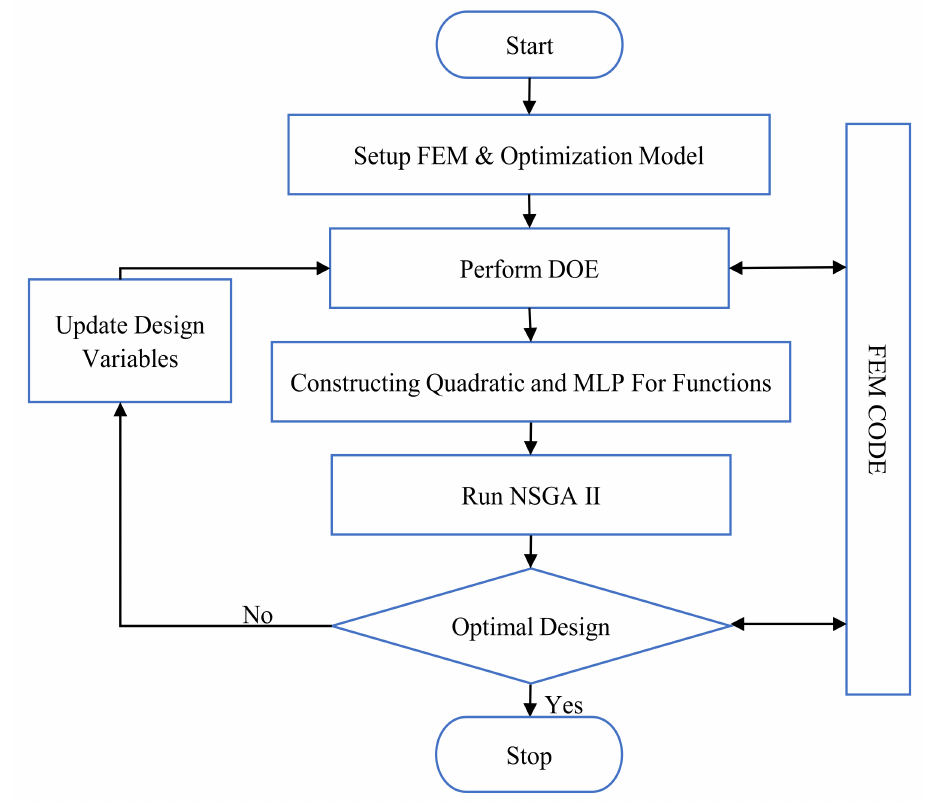
Figure 11. Optimization process